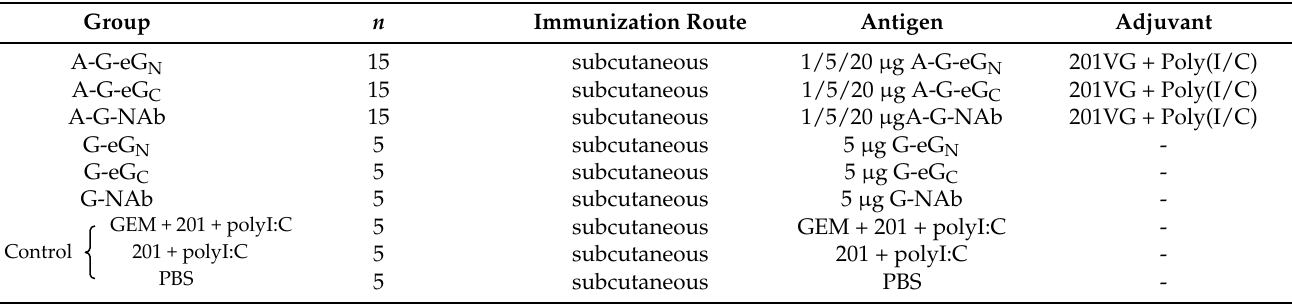
Table 2. The mouse vaccination